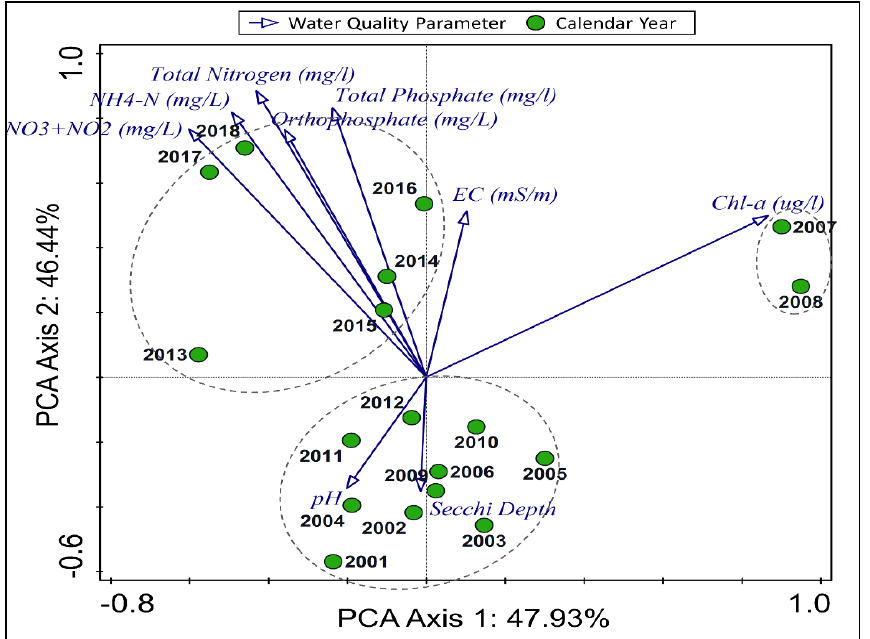
Figure 5. Principal Component Analysis (PCA) biplot indicating variation in selected water quality variables in Roodeplaat Dam from 2001 to 2018 at the dam wall (Site C). Individual data points are mean values representing each calendar year .